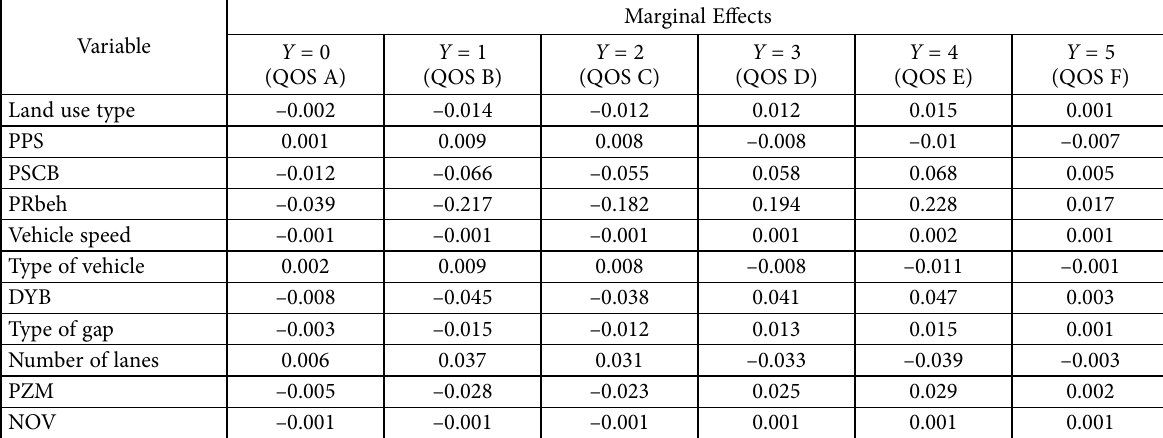
Table 5. Marginal effects of the pedestrian